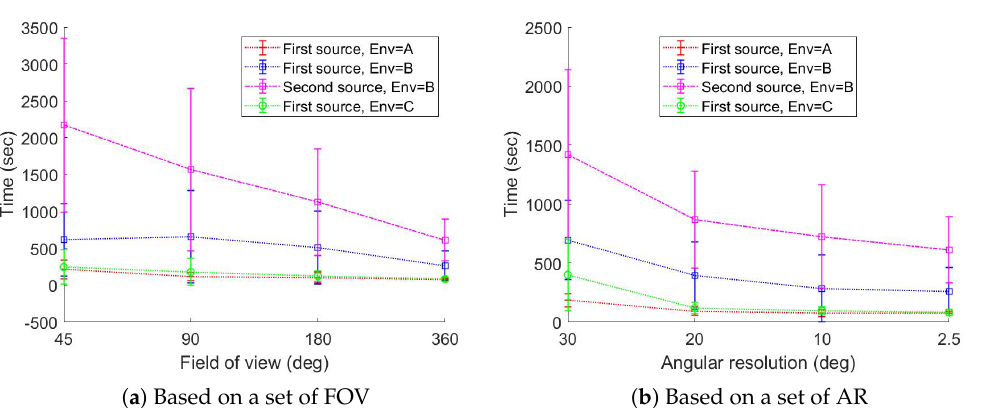
Figure 16. The time required for radioactive hotspot localization, average over ten